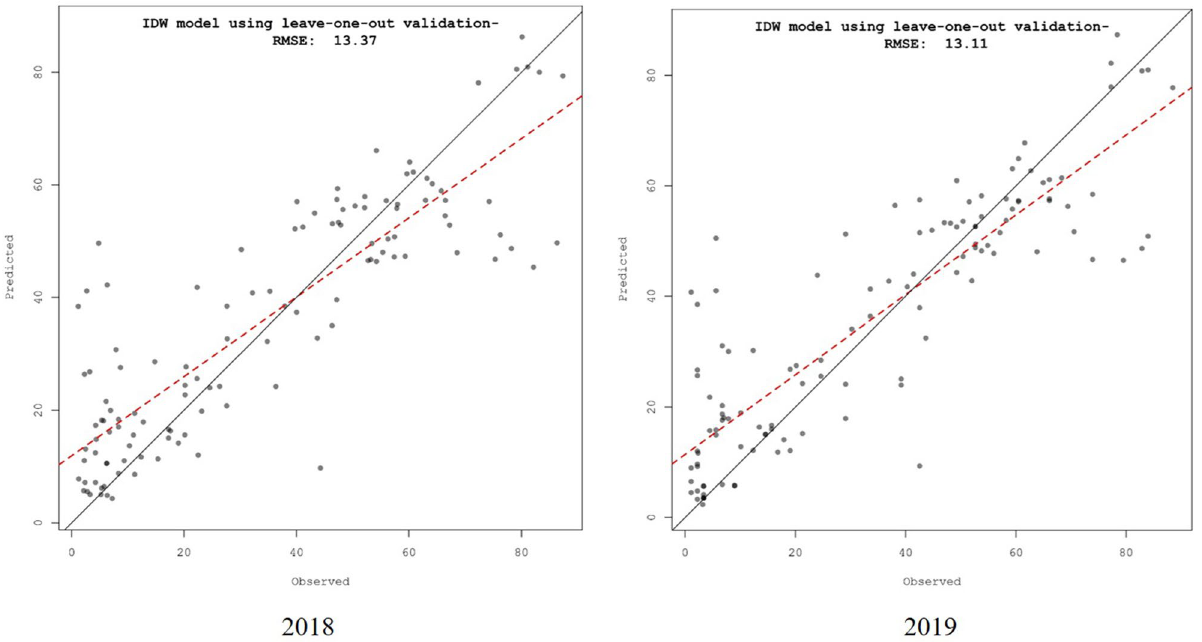
Figure 7. Scatter plot comparing predicted and observed values at the different sampled locations for RBD in Karnataka.